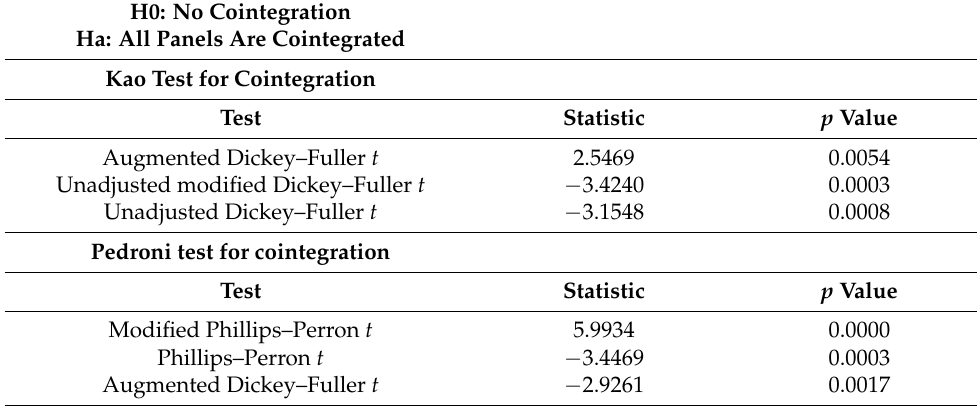
Table 8. Cointegration